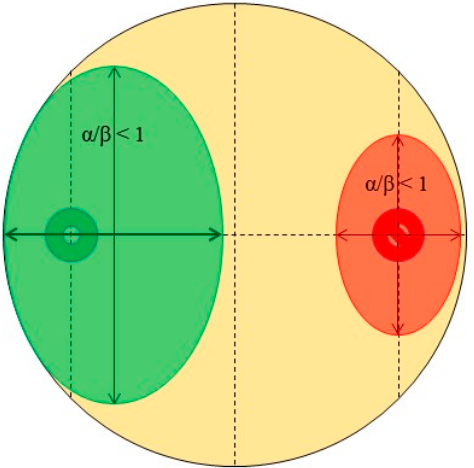
Figure 2. Example schematic antagonism assay plate where both the endophyte antagonist (green) as well as the pathogen (red) have a spherical index < 1.